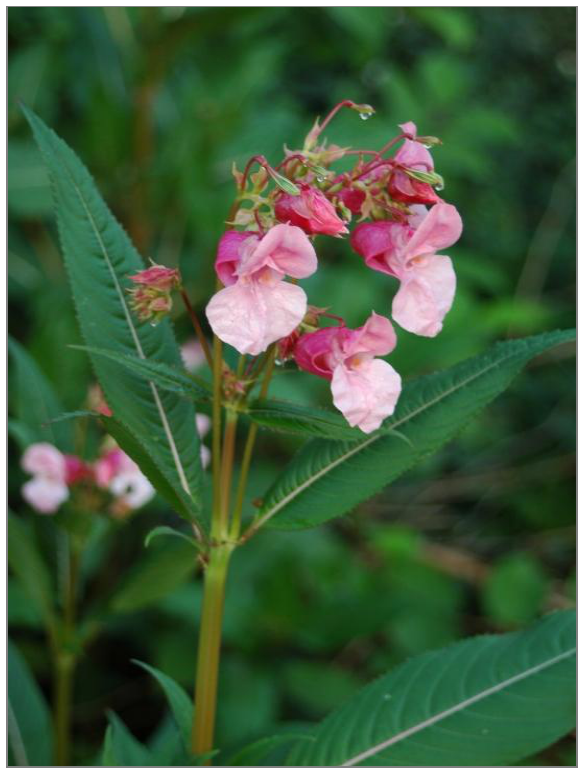
Fig. 2. Impatiens glandulifera in the Ślepiotka valley